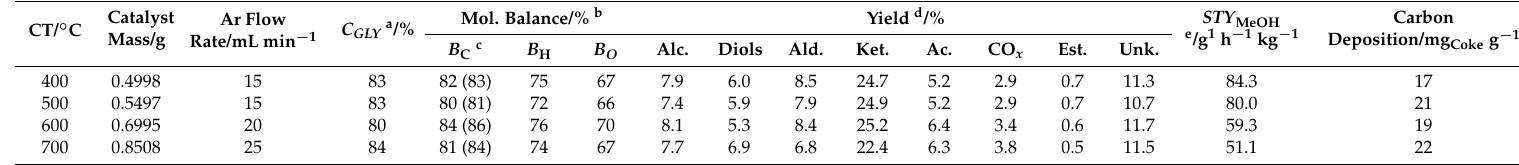
Table 4. Glycerol conversion and product yield distribution for reactions over CeO 2 calcined at different temperatures (CT) at a uniform catalyst bed surface area. CT/ ◦